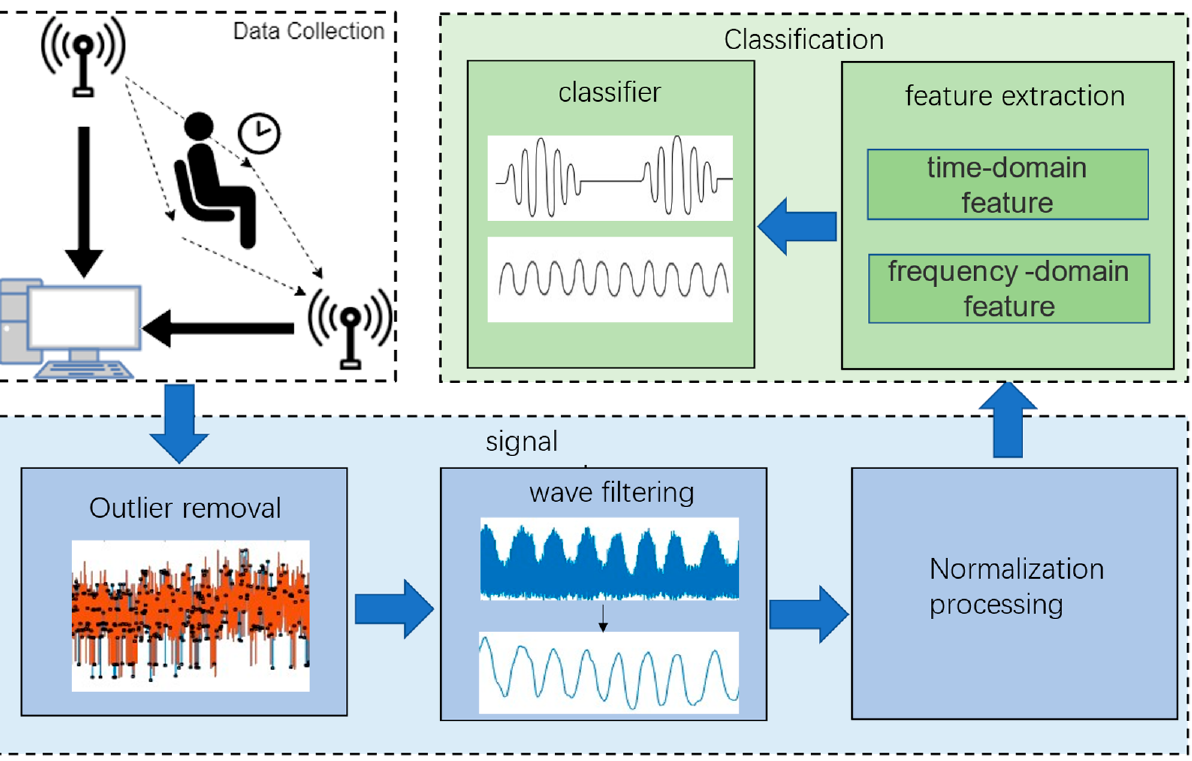
Figure 3. The system block diagram.